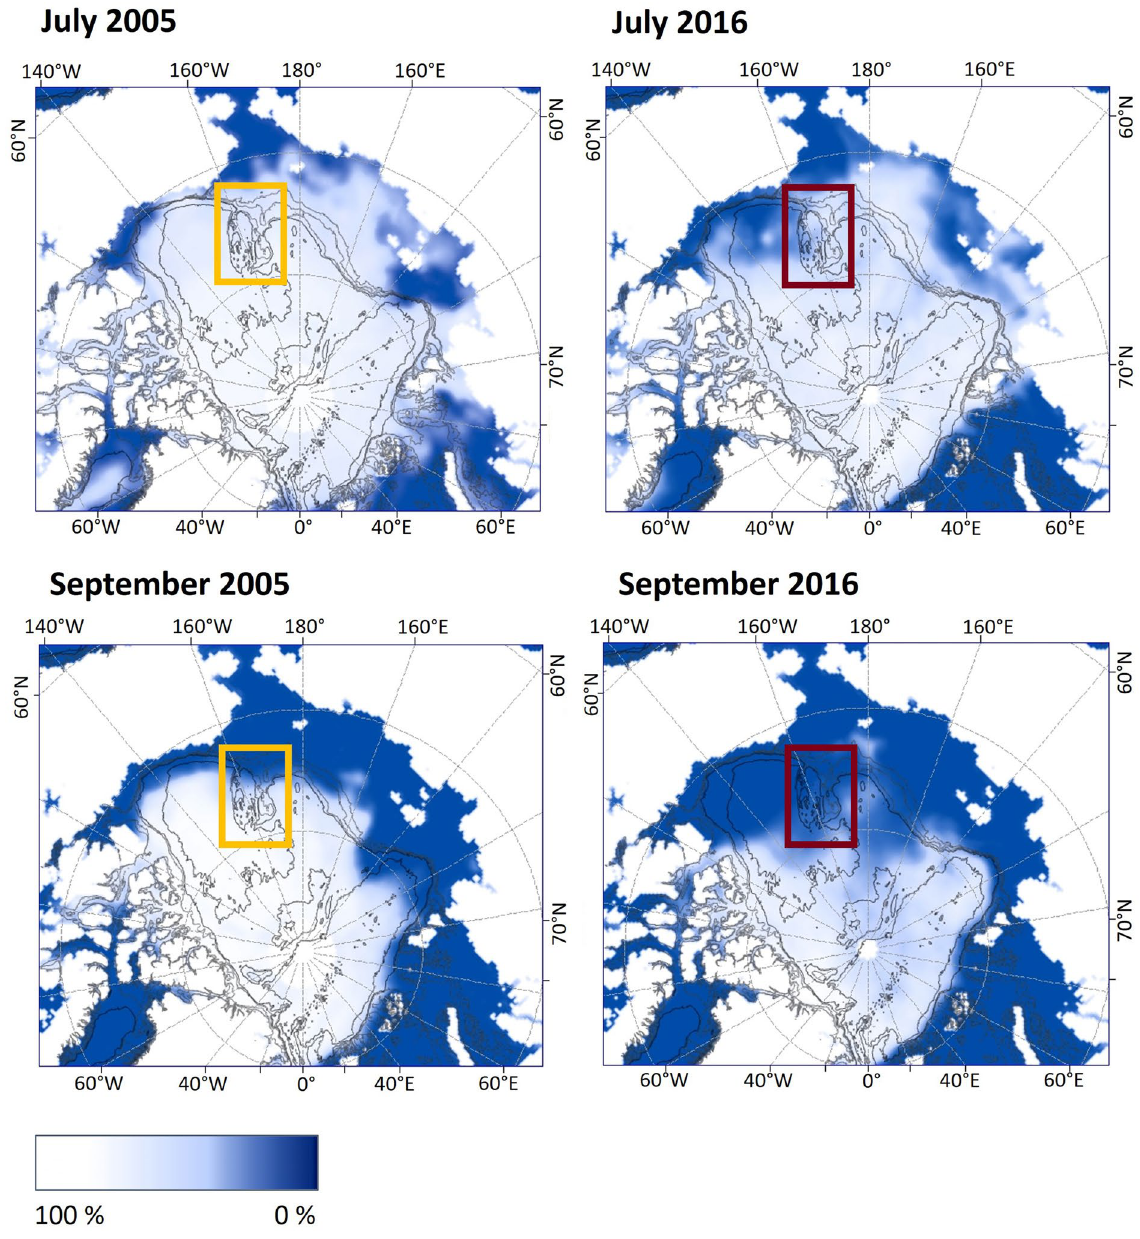
Figure 1. Comparison of sea ice concentration between the higher ice year, 2005 and the lower ice year, 2016, for July (upper panel, covers most of the sampling period for both years) and September (bottom panel, minimum ice month). The study area is marked by yellow and red rectangles for 2005 and 2016, respectively. Lowest ice concentrations are indicated by dark blue and highest concentrations are in white. Average sea-ice concentration data were derived from the National Snow and Ice Data Centre (https:// nsidc. org/ data/ NSIDC- 0051/ versi ons/1). The data were then imported into ESRI ArcGIS 10.5 software (http:// www. esri. com/ softw are/ arcgis/ arcgis- for- deskt op) and projected